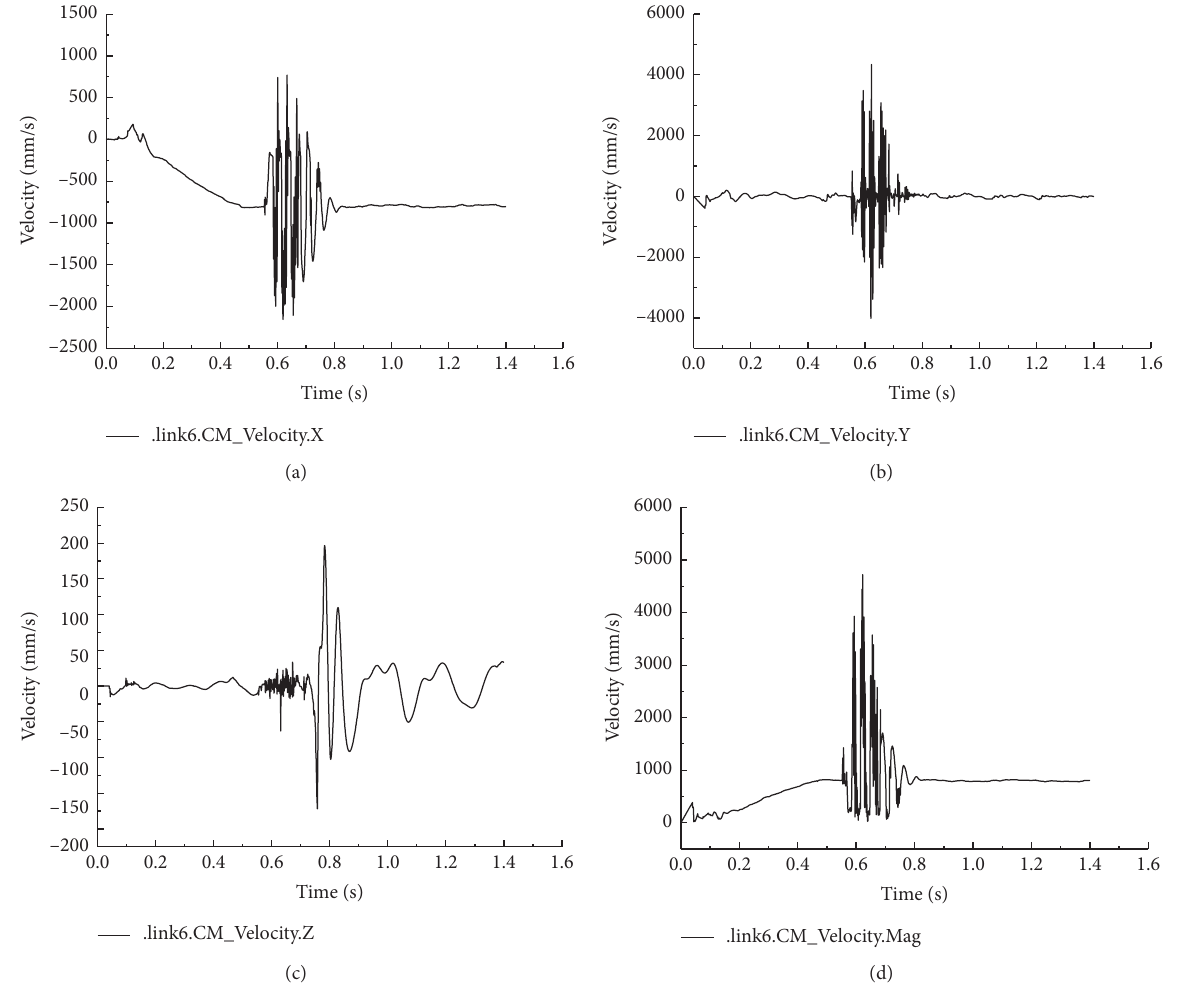
Figure 7: Link 6 velocity change curve. (a) Velocity in the X direction. (b) Velocity in the Y direction. (c) Velocity in the Z direction. (d) Velocity